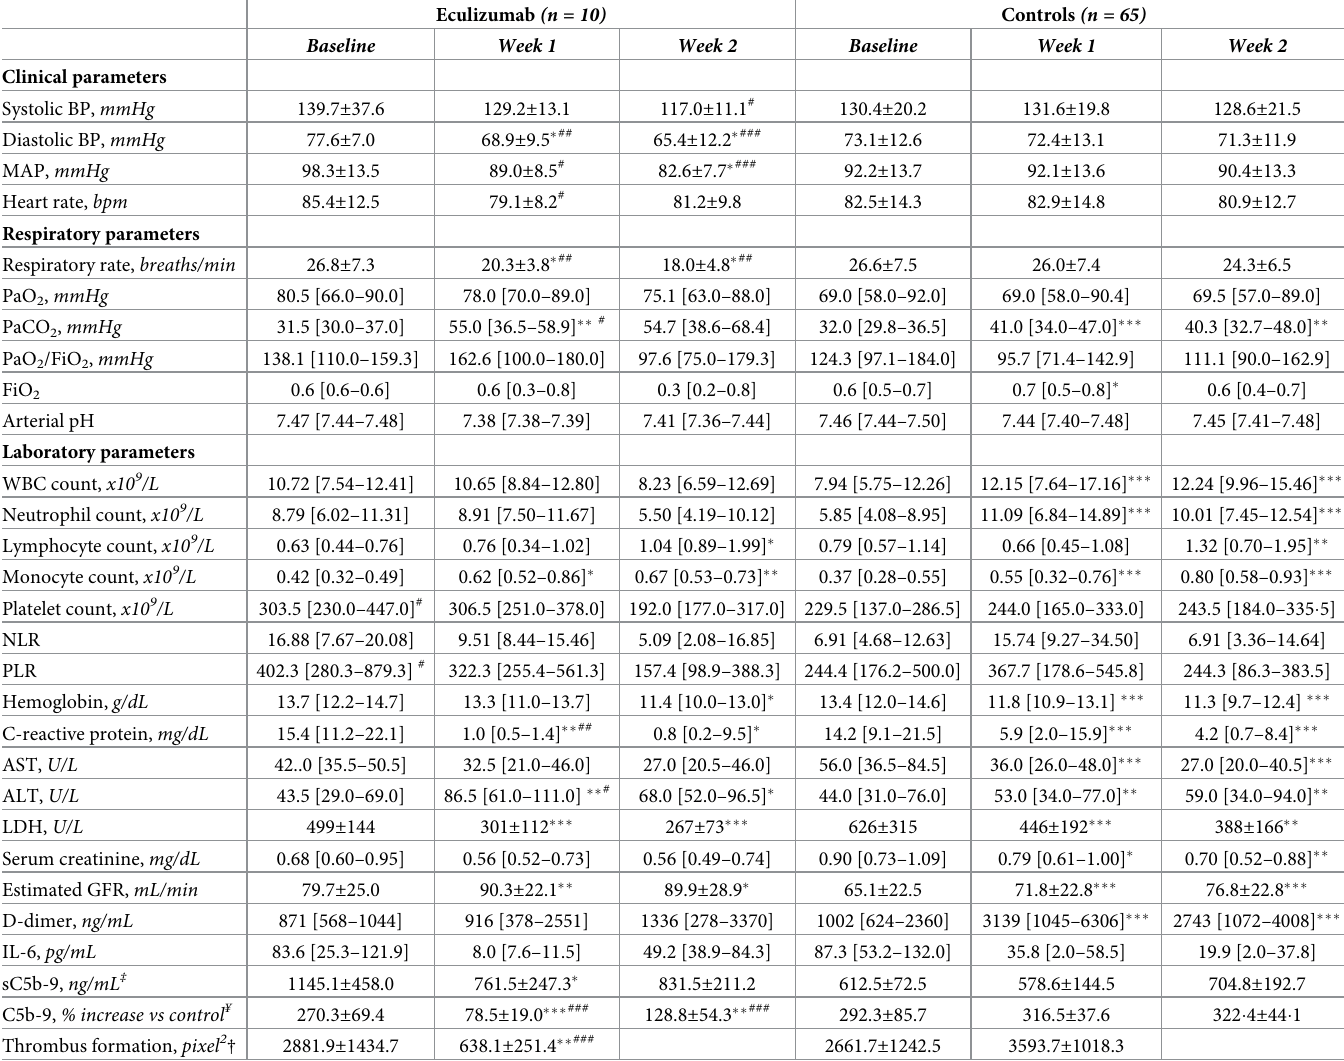
Table 2. Clinical, respiratory and laboratory parameters at baseline and during follow-up according to study